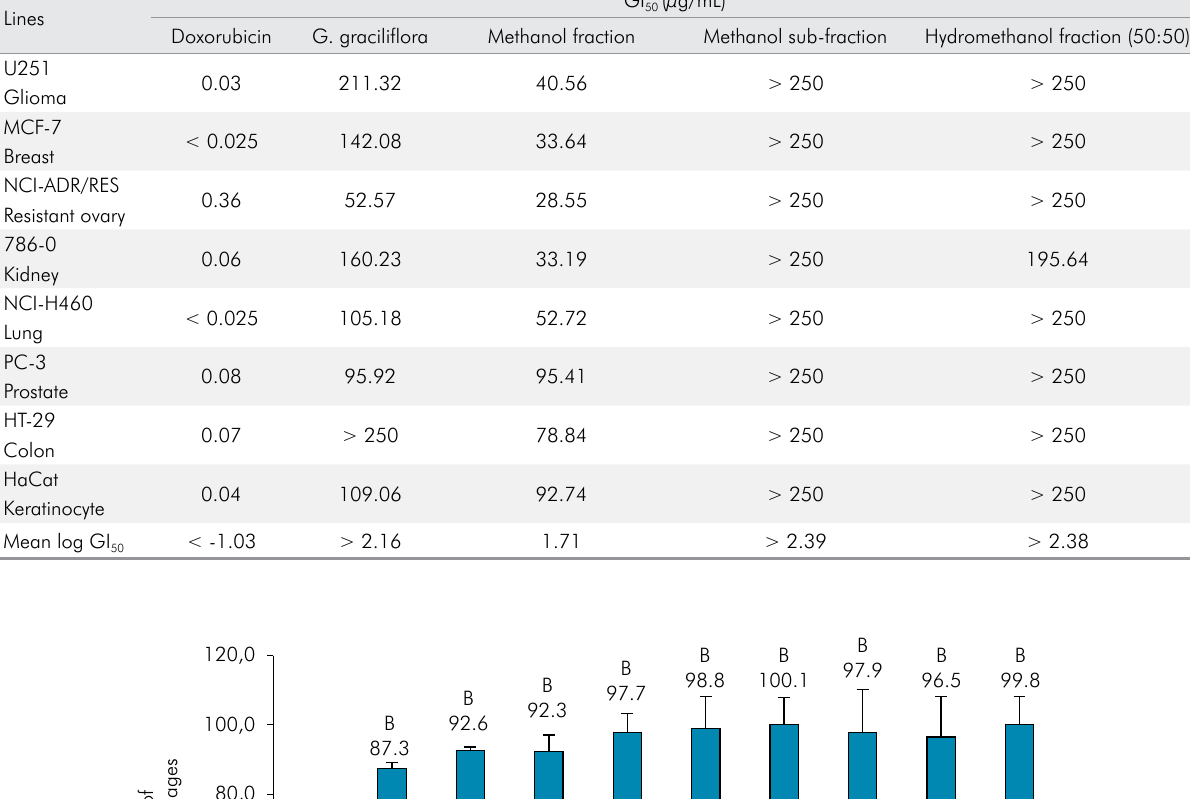
Table 3. Growth Inhibition 50 (GI50) (sample concentration necessary for 50% cell growth inhibition) of G. graciliflora and fractions for cultures of human tumor cell lines.